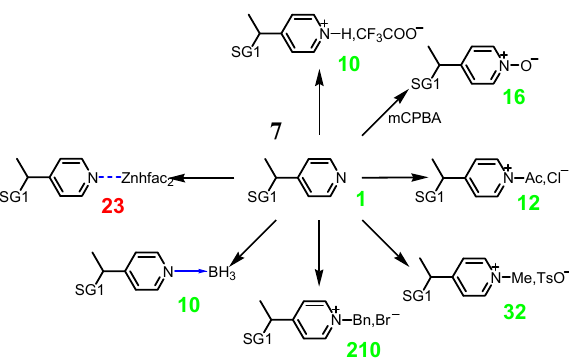
Figure 8. Various modes of activation of 7 . Bold (green for normal activation, red values for unexpected values for the coordination by Lewis acid) numbers are for relative k d values.